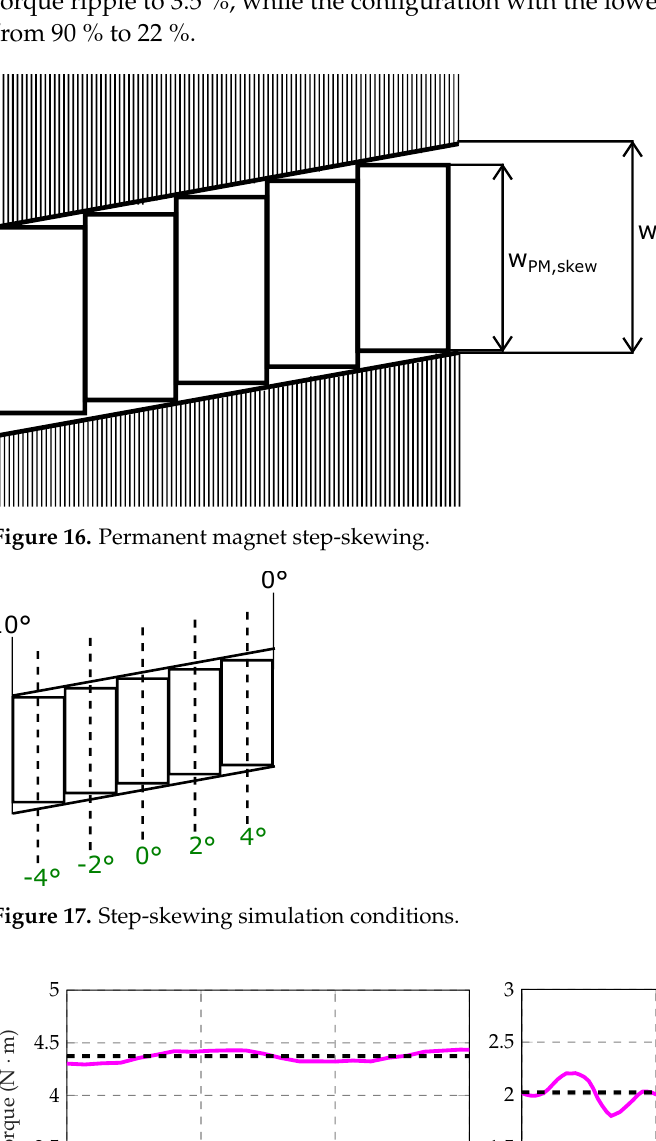
Table 3. Torque ripple with shaped rotor solution.